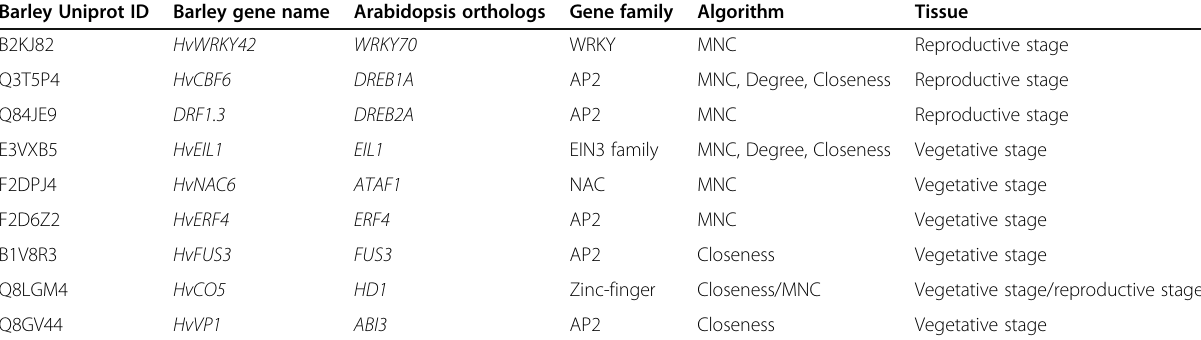
Table 4 The transcription factors which have been identified as hub genes Barley Uniprot ID Barley gene name Arabidopsis orthologs Gene family